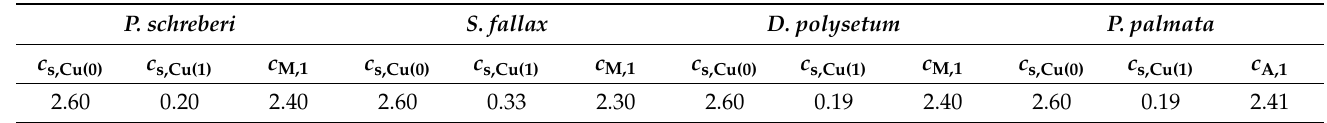
Table 3. Changes in Cu concentrations in solutions (mg/dm 3 ) and in mosses and algae (mg/g d.m.) during the sorption process ( n =